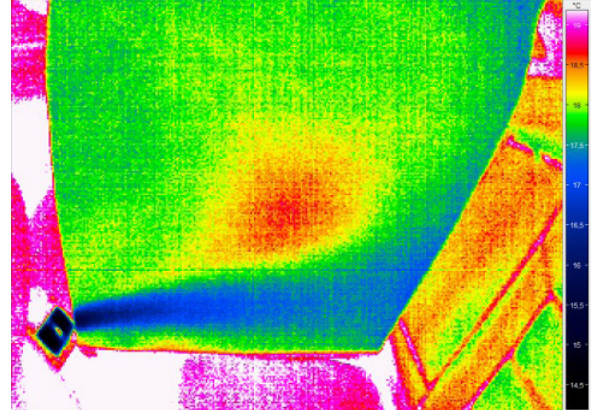
Fig. 8. The thermogram of measured temperature field in 2D cold airstream at rear row of seats from infrared camera on the hand-held measuring